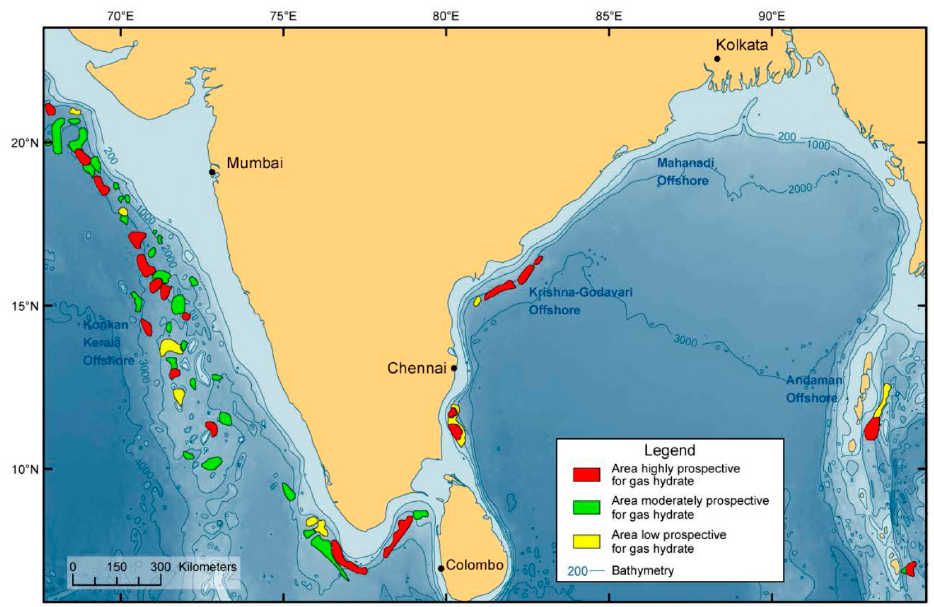
Figure 1. Locations of natural gas hydrate reservoirs observed in India [31] .